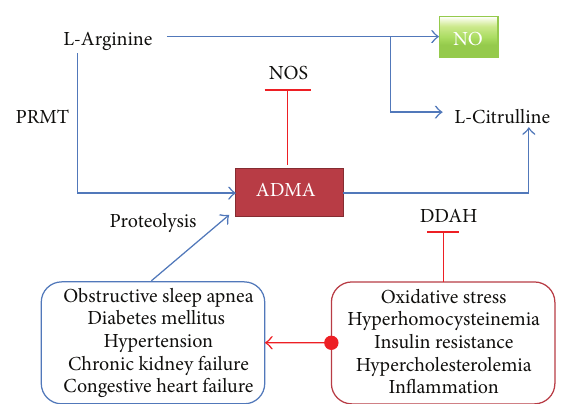
Figure 1: Pathology of ADMA. ADMA: asymmetric dimethylargi- nine; DDAH: dimethylarginine dimethylaminohydrolase; NO: nitric oxide; NOS: nitric oxide synthase; PRMT: protein arginine